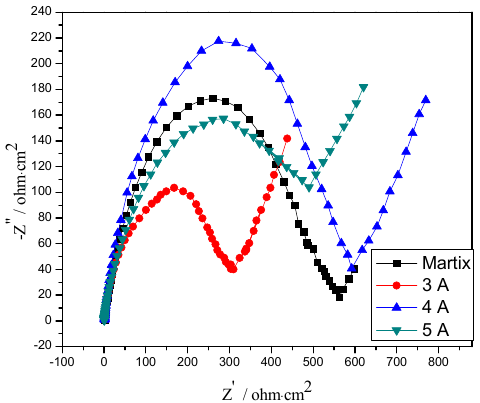
Figure 9. EIS analysis of CrN x coating under different filament currents.